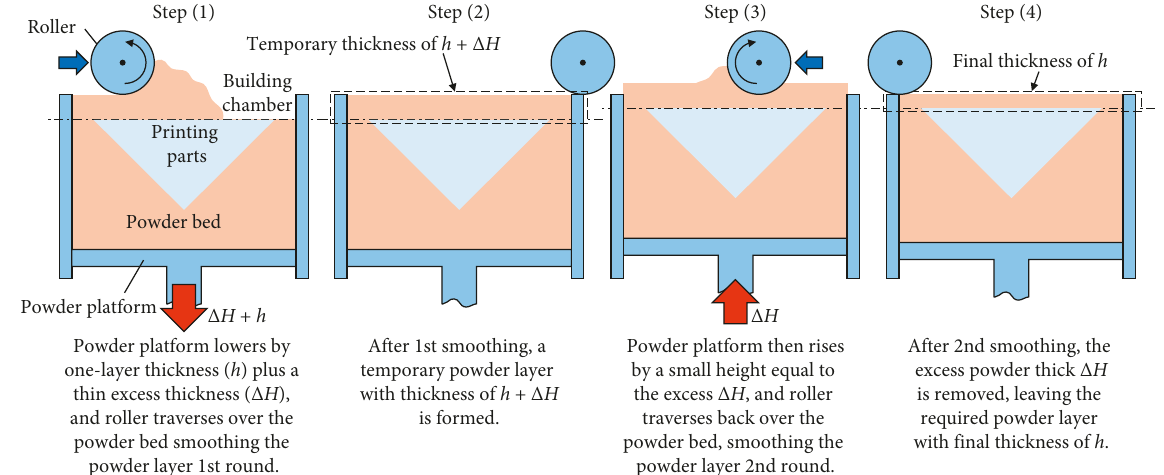
Figure 2: DS method (procedure for dispensing one powder layer with final thickness of h). Table 3: Experiment groups and their corresponding process setups. Group no.